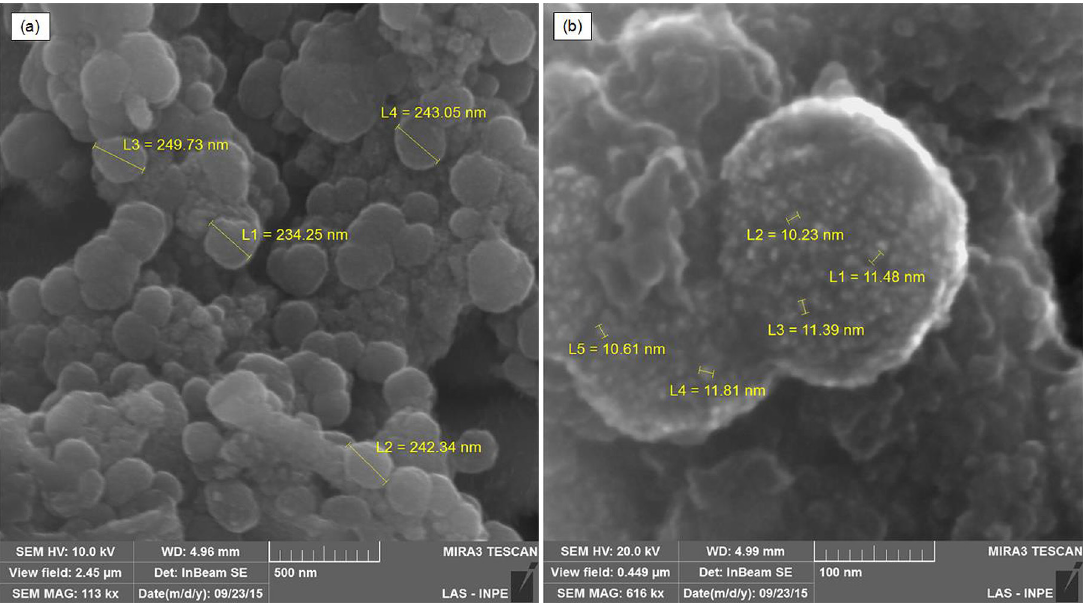
Figure 6. FEG-SEM images of BDUND/PS, in different magnifications (a) 113000x, showing grains agglomerates (b) 616000x, showing grain sizes.